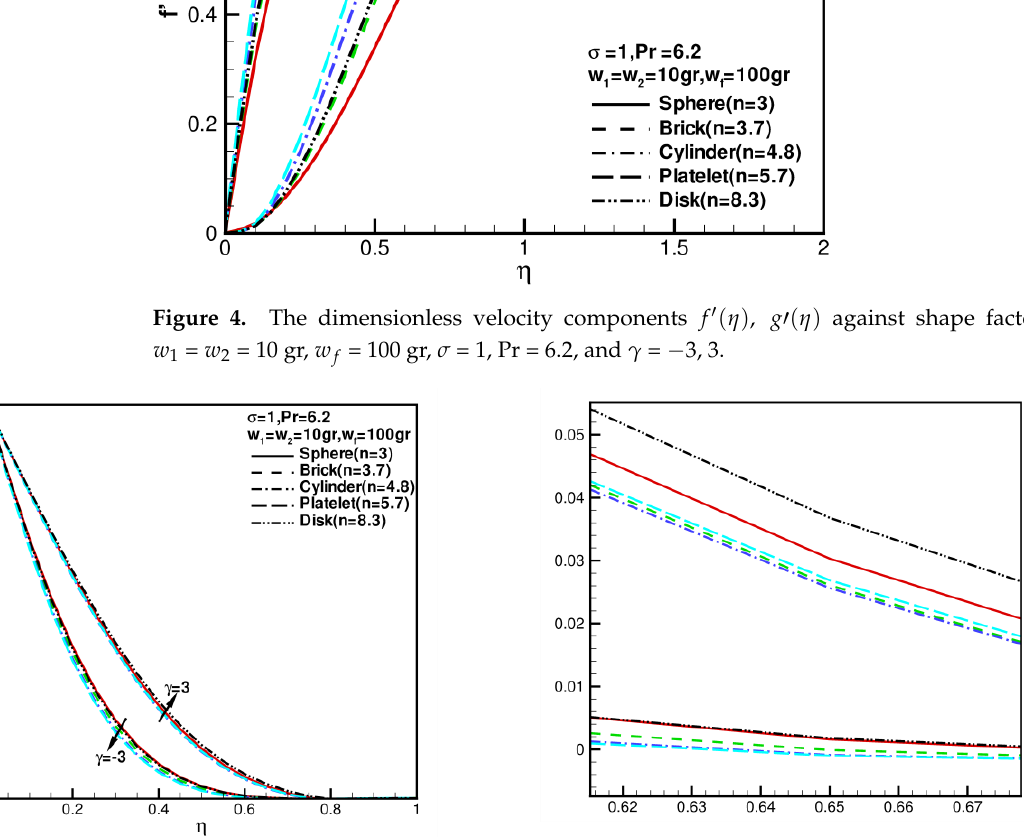
( a ) ( b ) Figure 5. The variations in dimensionless fluid temperature component θ ( η ) against the shape factor n when w 1 = w 2 = 10 gr, w f = 100 gr, σ = 1, Pr = 6.2, and γ = − 3, 3: ( a ) the full picture of θ ( η ) ; ( b ) the partial enlargement picture of θ ( η ) . In nanofluids or hybrid nanofluids, the shape of nanoparticles affects both thermal characteristics and flow characteristics. A plot showing the influence of the shape factor n of nanoparticles on the skin friction coefficients and local Nusselt number can be seen in Figure 6. The skin friction coefficients of C f x , C f y and the local Nusselt number Nu x against γ in the range of − 6 ≤ γ ≤ 6 for various shape factors n 1 = n 2 = 3, 3.7, 4.8, 5.7, and 8.3 when w 1 = w 2 = 10 gr, w f = 100 gr, σ = 0, and Pr = 6.2 are shown in Figure 6. The values of C f x , C f y show a symmetric pattern where the line of symmetry lies at γ = 0 in